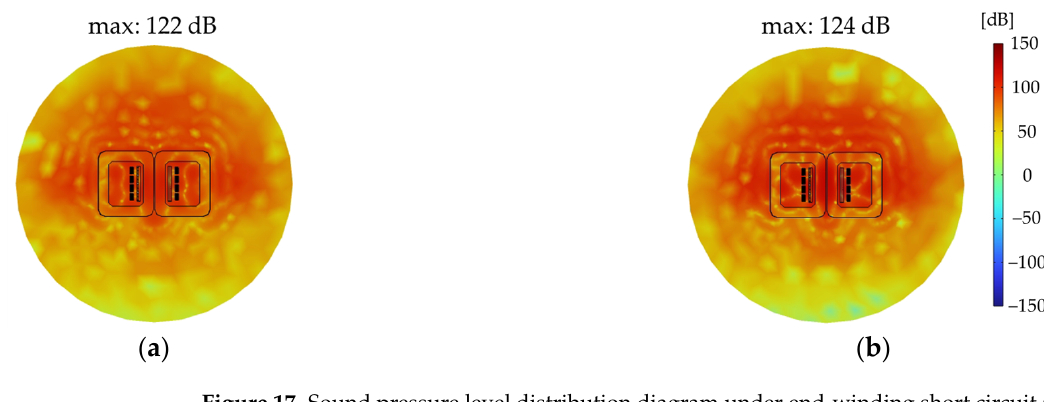
Figure 17. Sound pressure level distribution diagram under end-winding short circuit ( a ) Inter- leaved winding; ( b ) Continuous winding.